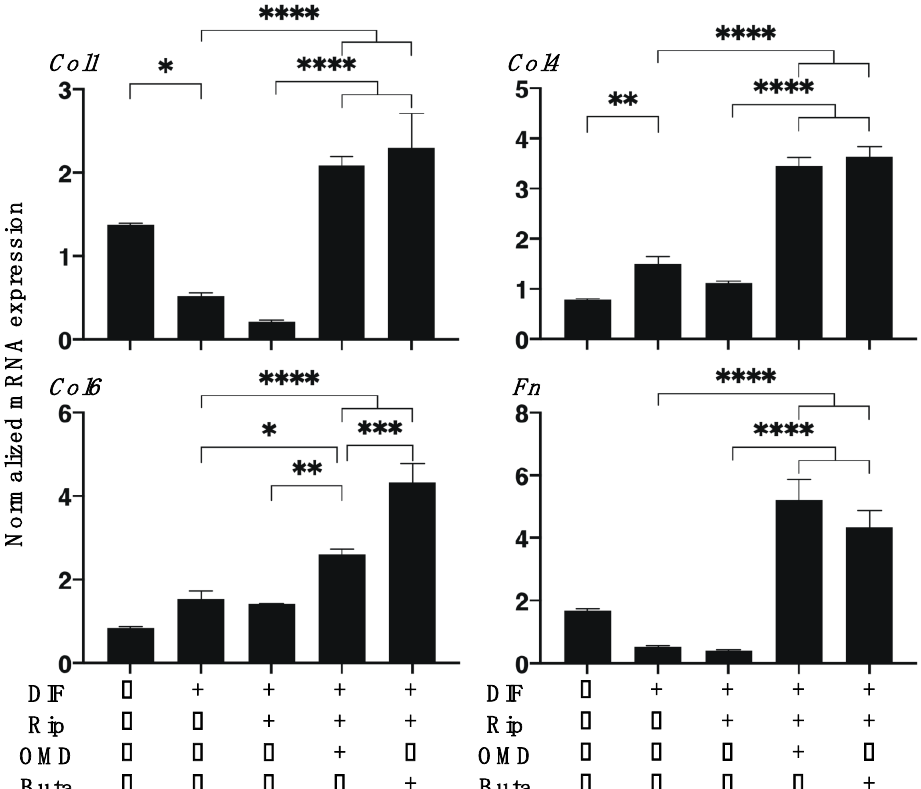
Figure 2. Additive effects of EP2 agonists to ripasudil (Rip) on the mRNA expression of ECMs of 2D cultured 3T3-L1 cells. The 2D cultures of 3T3-L1 cells were prepared under several sets of conditions: preadipocytes of 3T3-L1 cells (DIF-) or adipogenic differentiation (DIF+) with or without a combination of 10 µ M ripasudil (Rip) and the EP2 agonist, 100 nM omidenepag (OMD) or 100 nM butaprost (Buta). These specimens were subjected to a qPCR analysis to estimate the expression of the mRNA of the major ECMs ( Col1 : collagen 1; Col4 : collagen 4; Col6 : collagen 6; Fn : fibronectin). All experiments were performed in triplicate using fresh preparations, and each experiment consisted of 5 samples. Data are presented as the arithmetic mean ± the standard error of the mean (SEM). * p < 0.05, ** p < 0.01, *** p < 0.005, **** p < 0.001 (ANOVA followed by a Tukey’s multiple comparison test).